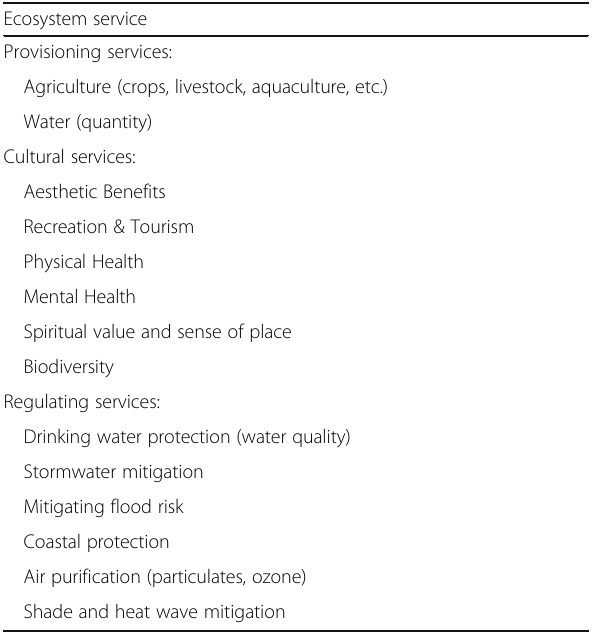
Table 1 Ecosystem services of greatest relevance to cities, classified according to the scheme of the Millennium Ecosystem Assessment [75, 115]. Adapted from McDonald [30] Ecosystem